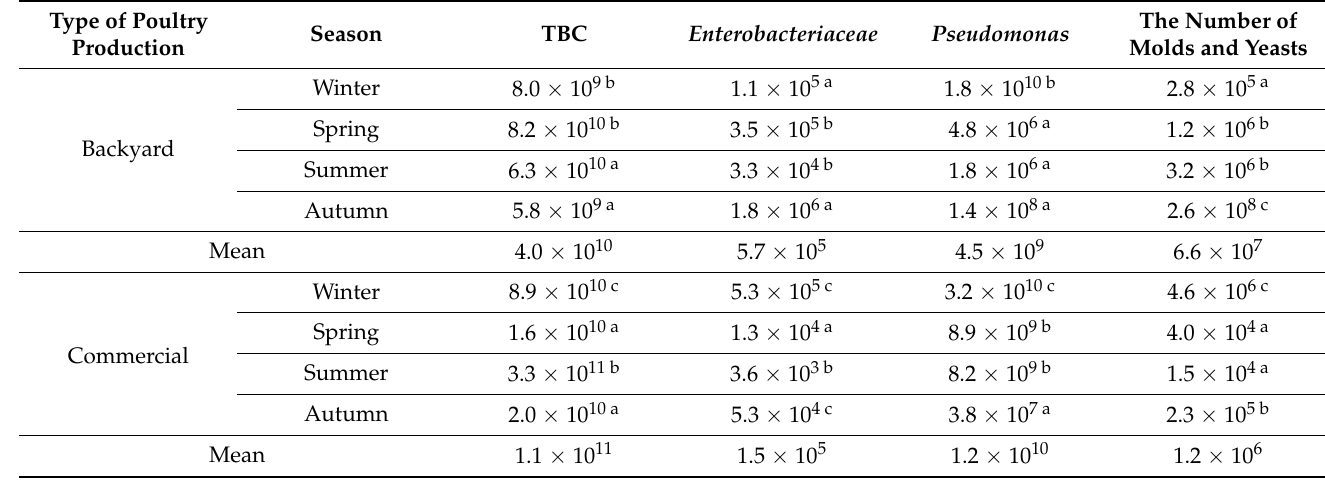
Table 4. Average microbial contamination (CFU/g) of the